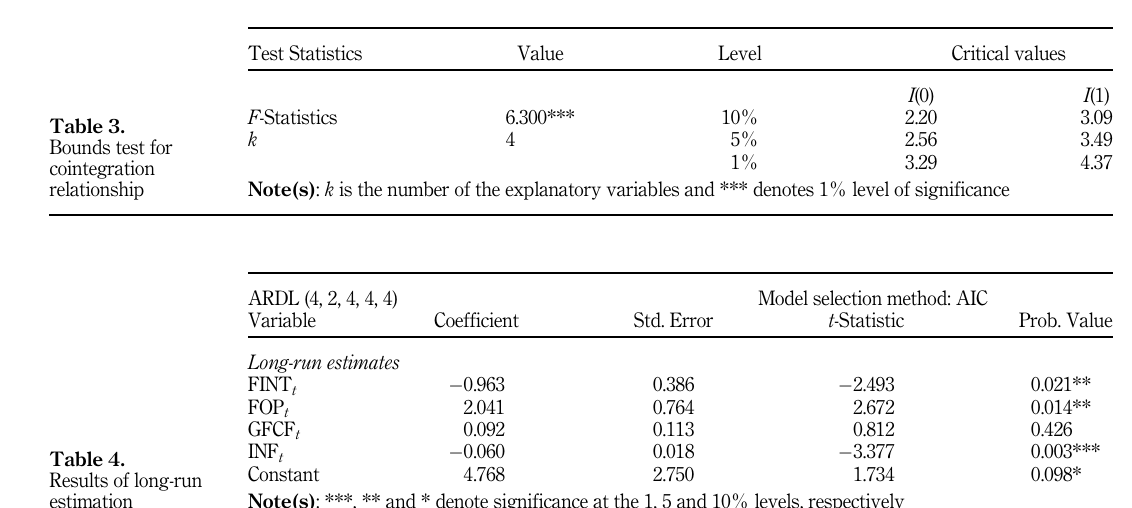
Table 4. Results of long-run